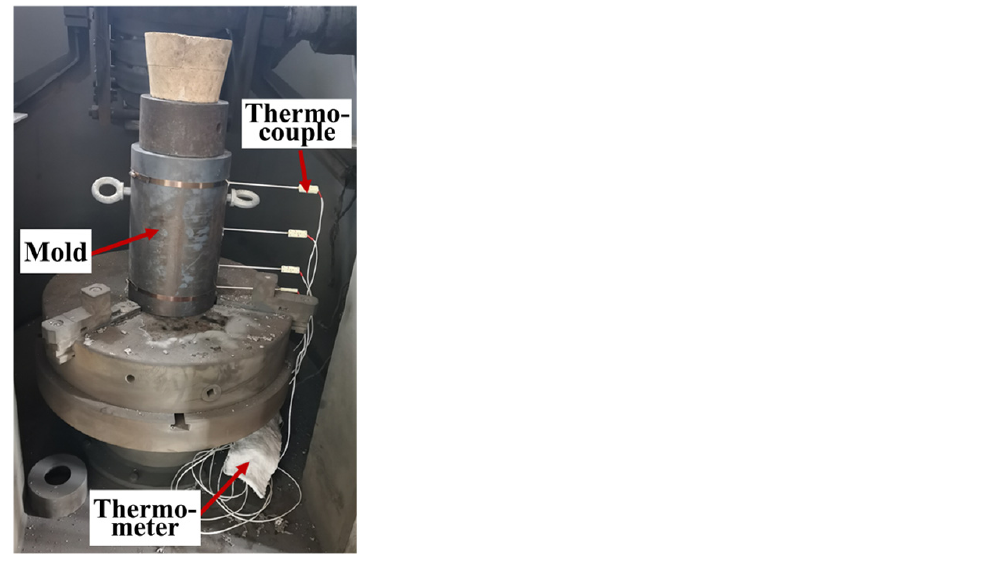
Figure 2. Experimental set-up of experimental casting mold and temperature measurement system.